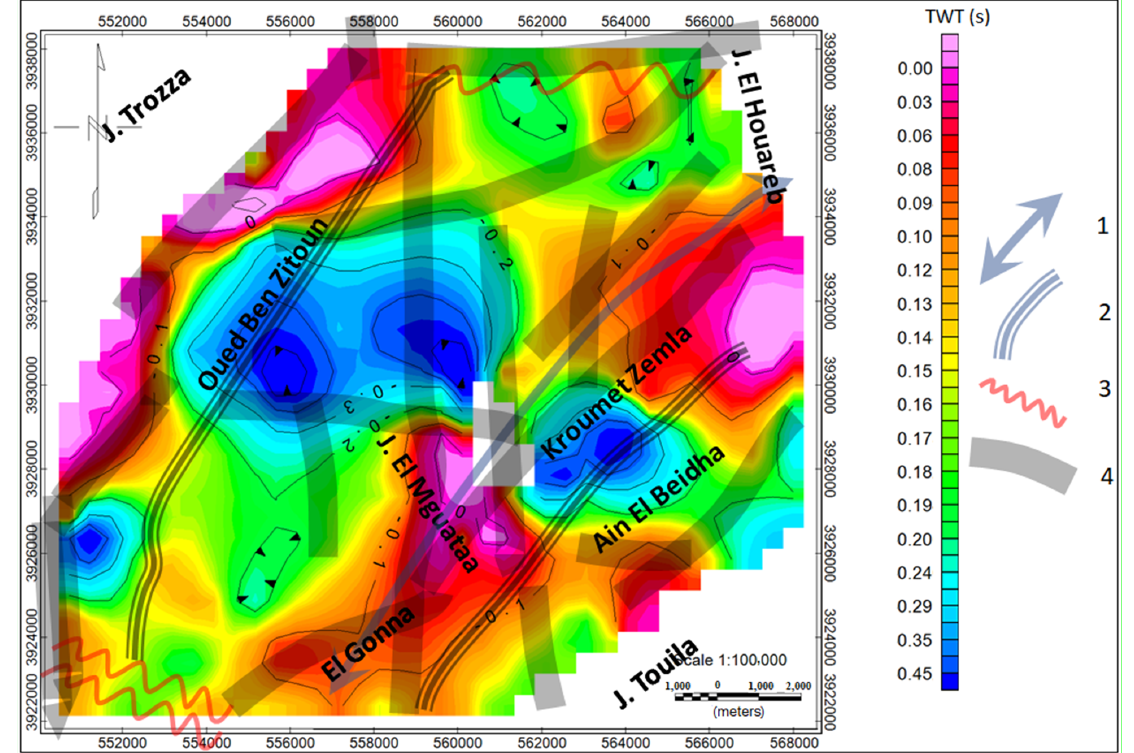
Figure 14. Thickness TWT map of the Oligocene aquifer. (1) Major positive gravity anomaly axis. (3) Major negative gravity anomaly axis. (4) Northern and southern limits of the Ain El Beidha plain. (4) Major fault/discontinuity corridors.